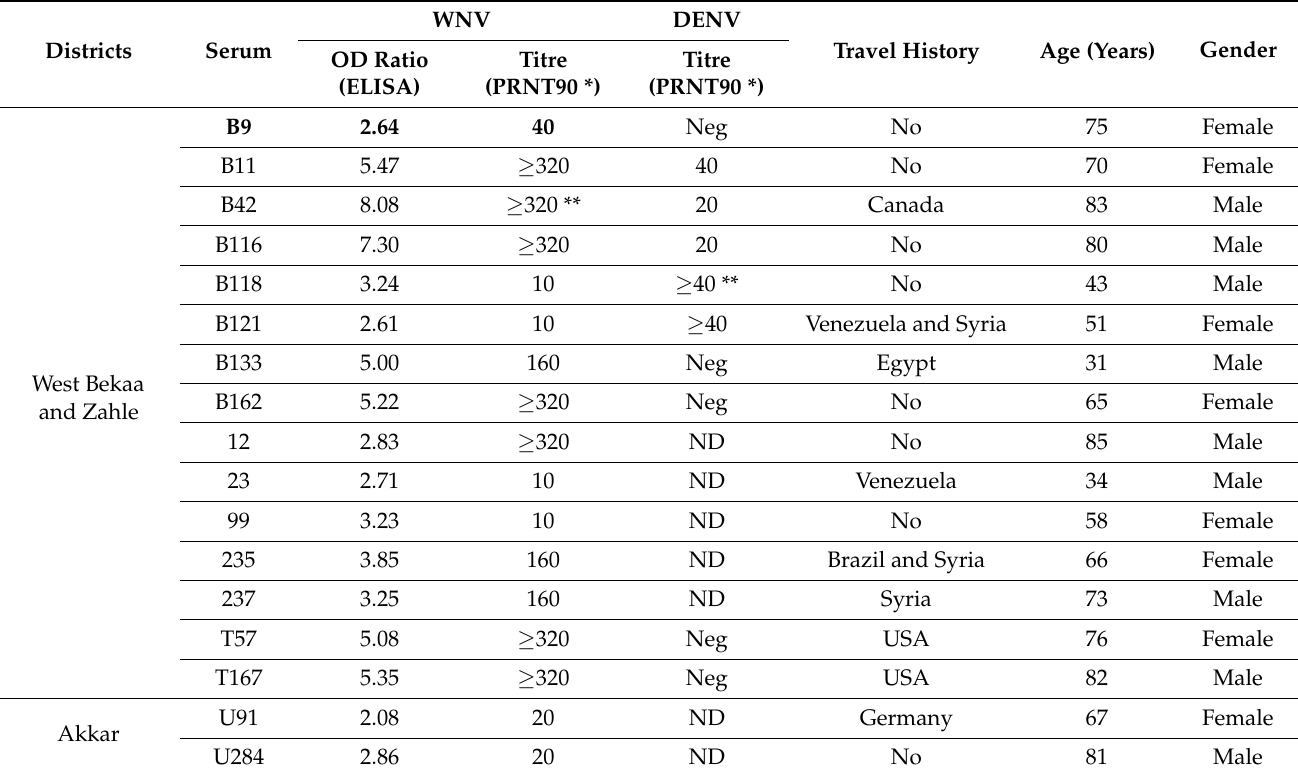
Table 1. List of seropositive humans that had WNV- and DENV-neutralizing antibodies by PRNT at titres ≥ 10.